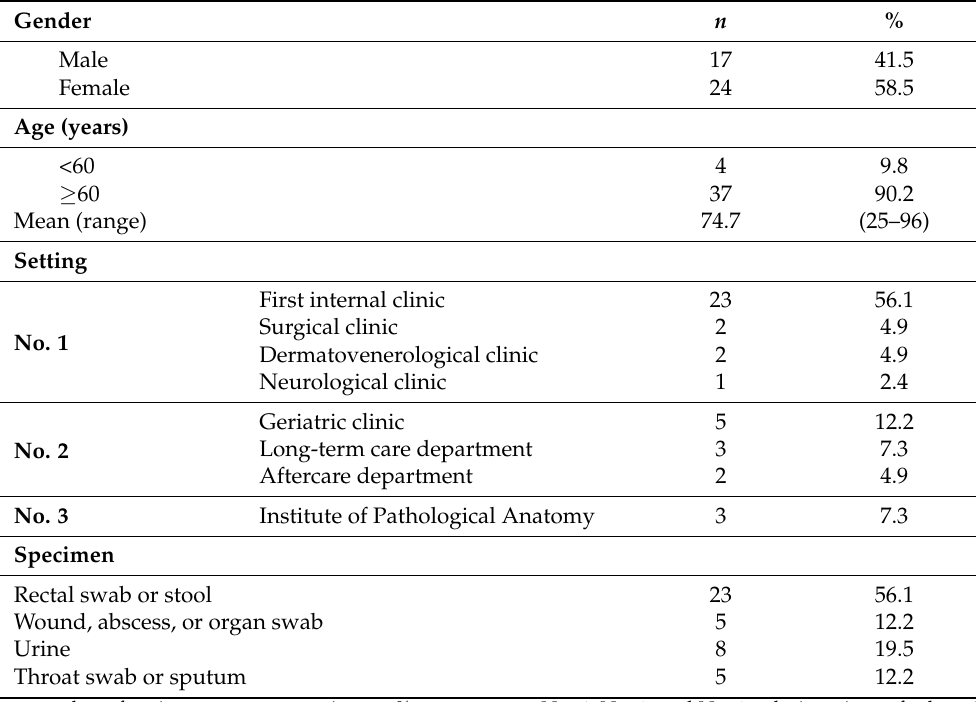
Table 1. Characteristics of the patients, healthcare settings, and specimens related to 41 CR Klebsiella pneumoniae strains.